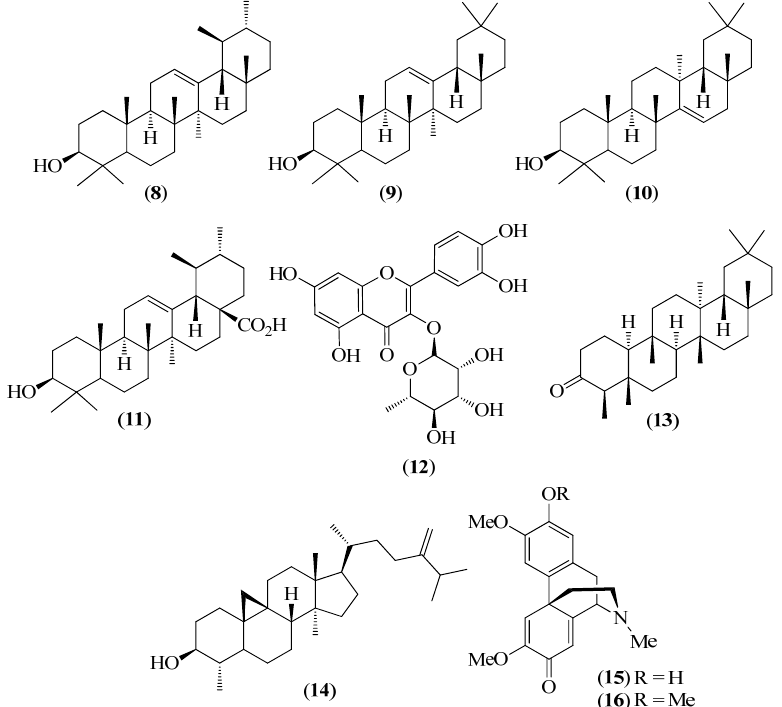
Figure 3. Structures of compounds 8 – 12 from Bejaria resinosa and 13 – 16 from Croton ferrugineus .